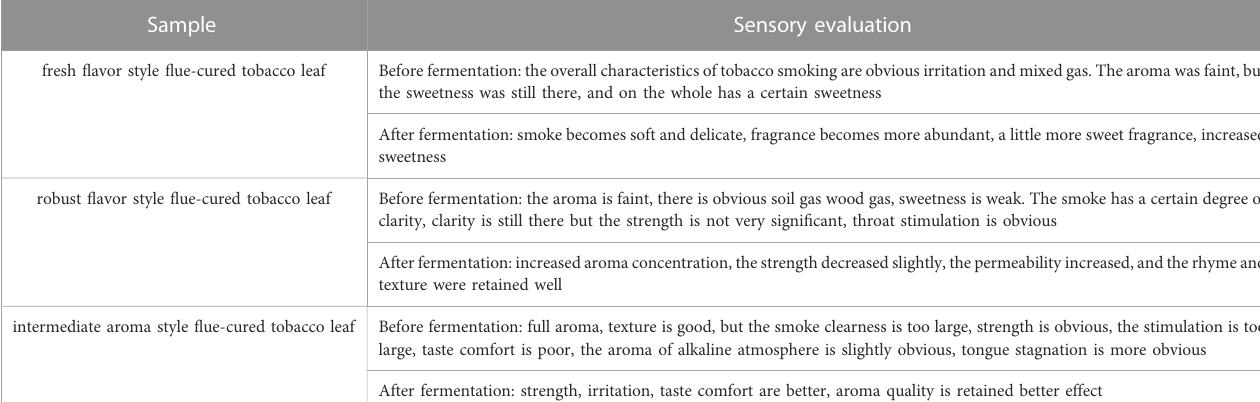
TABLE 1 Sensory evaluation results of 44# strain on low-grade tobacco leaves. Sample Sensory